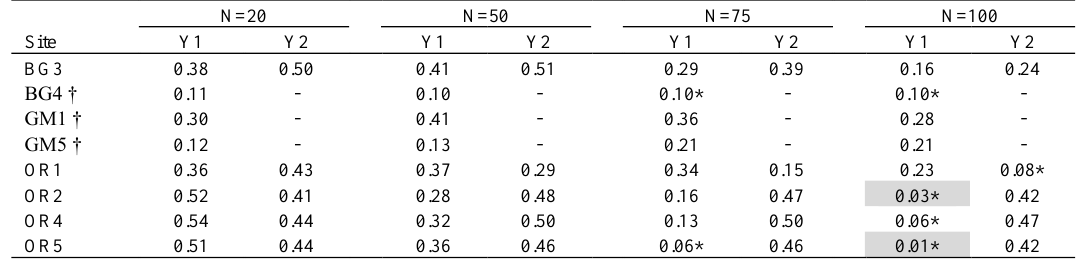
Table A4.1: P-values from Moran's I tests of spatial correlation in the residuals of logistic regressions with dependent variables Y (smallholder expansion) and Y (smallholder abandonment) for different 1 2 sample sizes. Shaded cells indicate instances in which the spatial correlation is significant at the 5% level. N=20 N=50 N=75